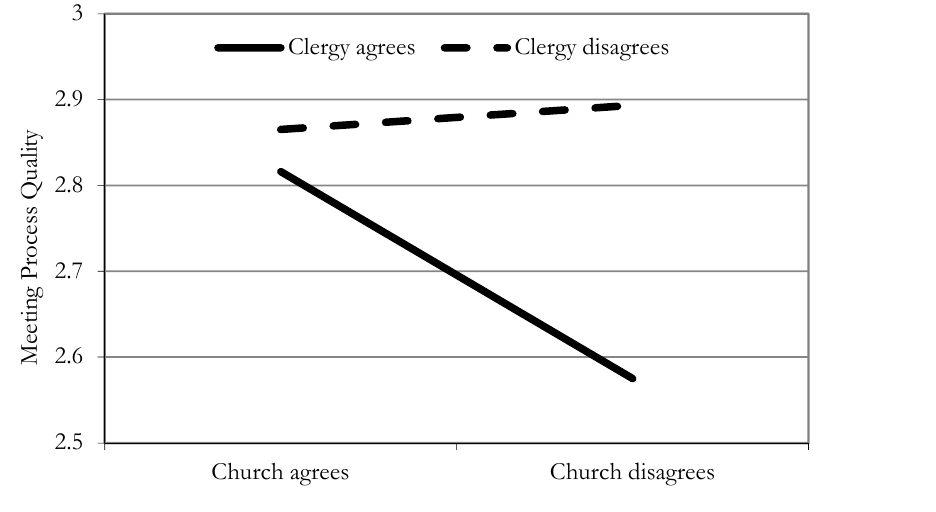
Source: 2009-2010 ELCA Clergy Surveys. Results from Table 2.